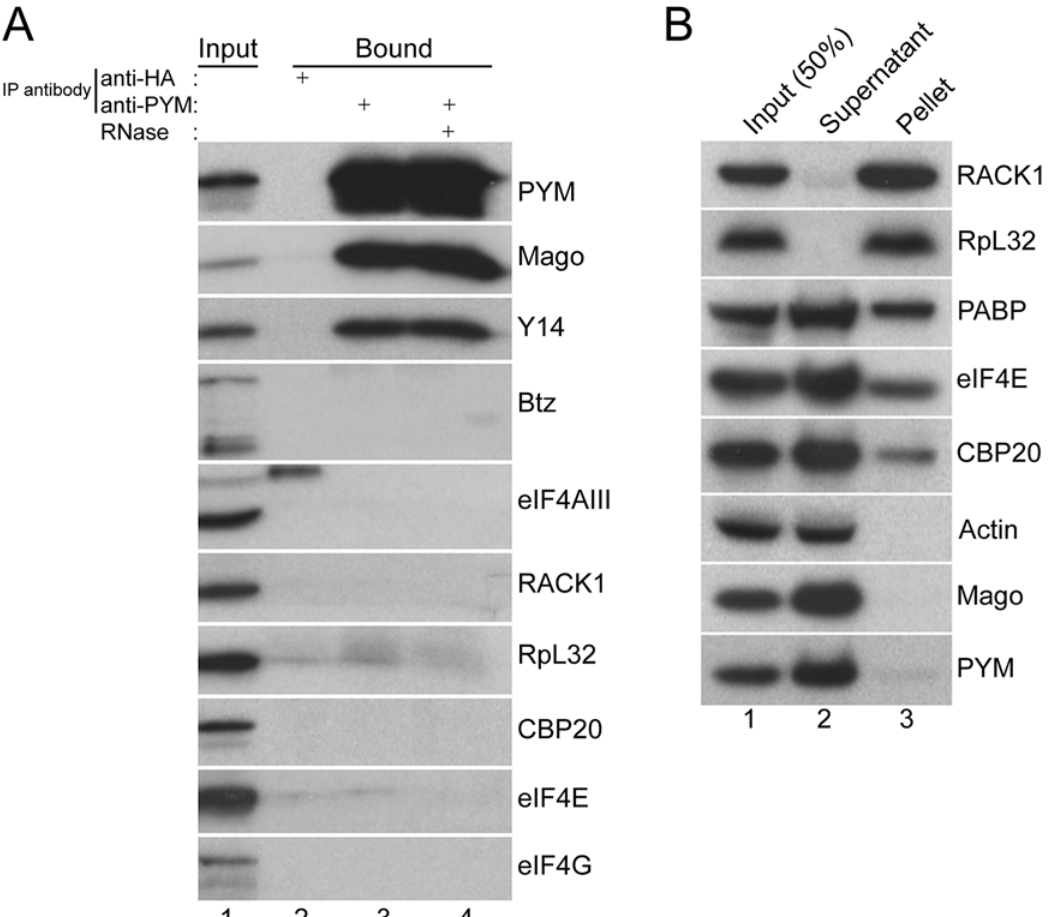
Fig 2. Endogenous Dm PYM interacts with Y14 and Mago but not with ribosomes. (A) Immunoprecipitation using anti-HA (lane 2) and anti-PYM (lane 3) antibody was performed using wild-type ovarian extracts. The precipitated proteins were analyzed by western blotting and stained with the antibodies indicated at the right of the panel. Lane 4 shows the anti-PYM precipitate from an extract treated with RNase. Input (1%) is shown in lane 1. (B) Sucrose cushion centrifugation of wild-type cytoplasmic ovarian extract. The input (lane 1; 50%), supernatant (lane 2) and pellet (lane 3) fractions were processed for western blot analysis and stained with the antibodies indicated at the right of the